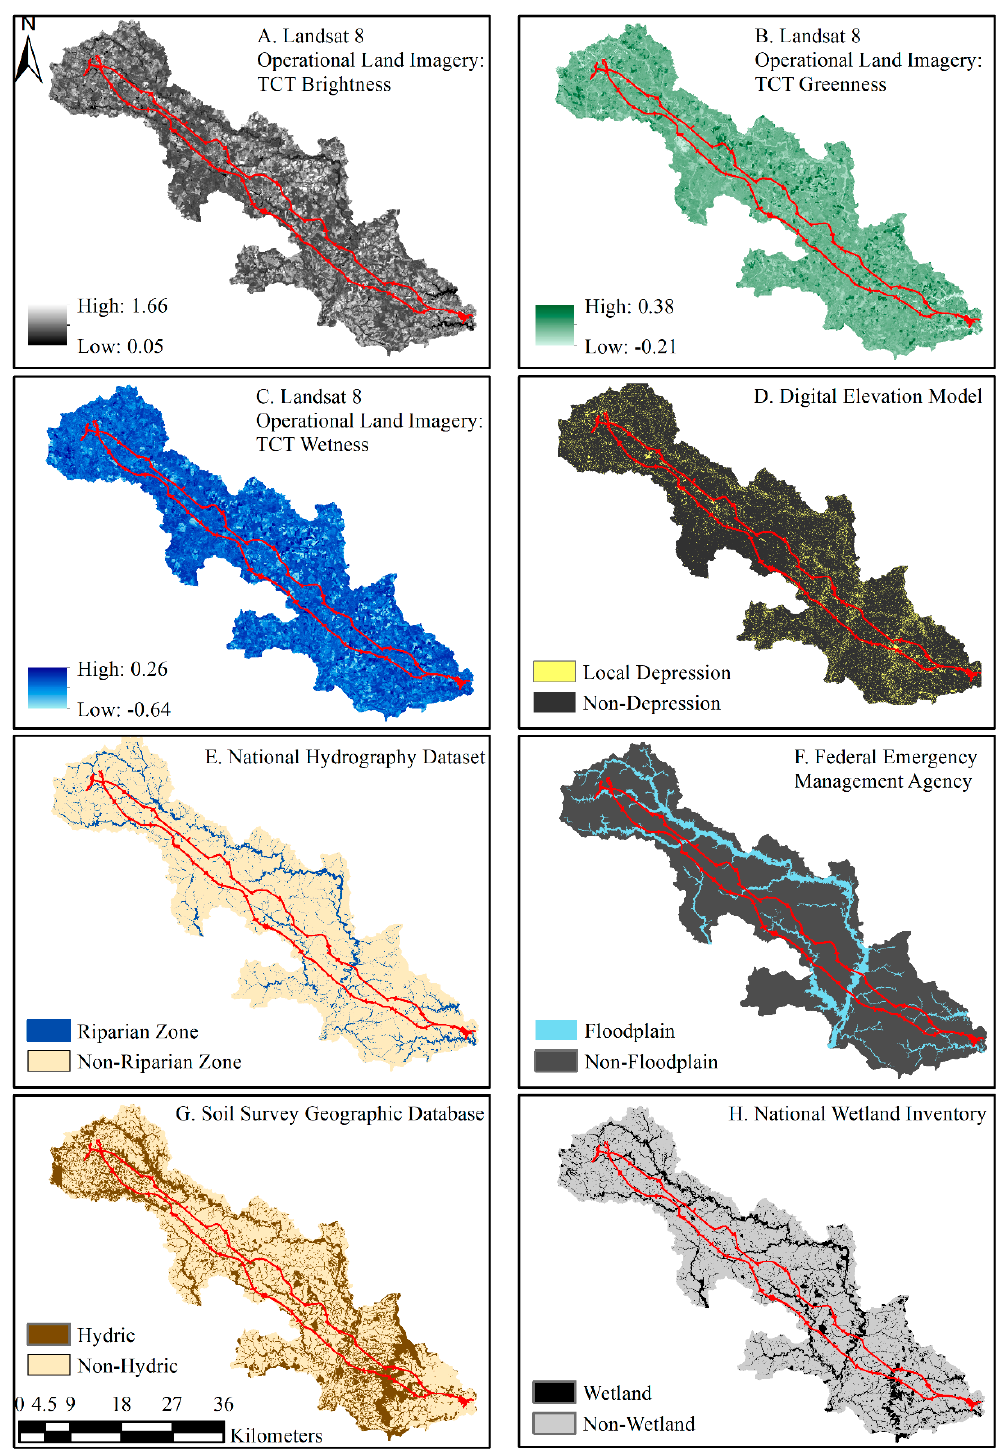
Figure 4. Input datasets to the wetland screening tool, excluding NLCD data which is described in Table 2, and the dataset source. Note, while the NWI data is not included in the classification, it is incorporated in post-classification steps. ( A ) Landsat 8 Operational Land Imagery: TCT Brightness; ( B ) Landsat 8 Operational Land Imagery: TCT Greenness; ( C ) Landsat 8 Operational Land Imagery: TCT Wetness; ( D ) Digital Elevation Model; ( E ) National Hydrography Dataset; ( F ) Federal Emergency Management Agency; ( G ) Soil Survey Geographic Database; ( H ) National Wetland Inventory. The satellite imagery processing consists of performing a Tasseled Cap Transformation (TCT) on the Landsat 8 OLI bands 2–7. The TCT is used to reduce dimensionality from several bands to a